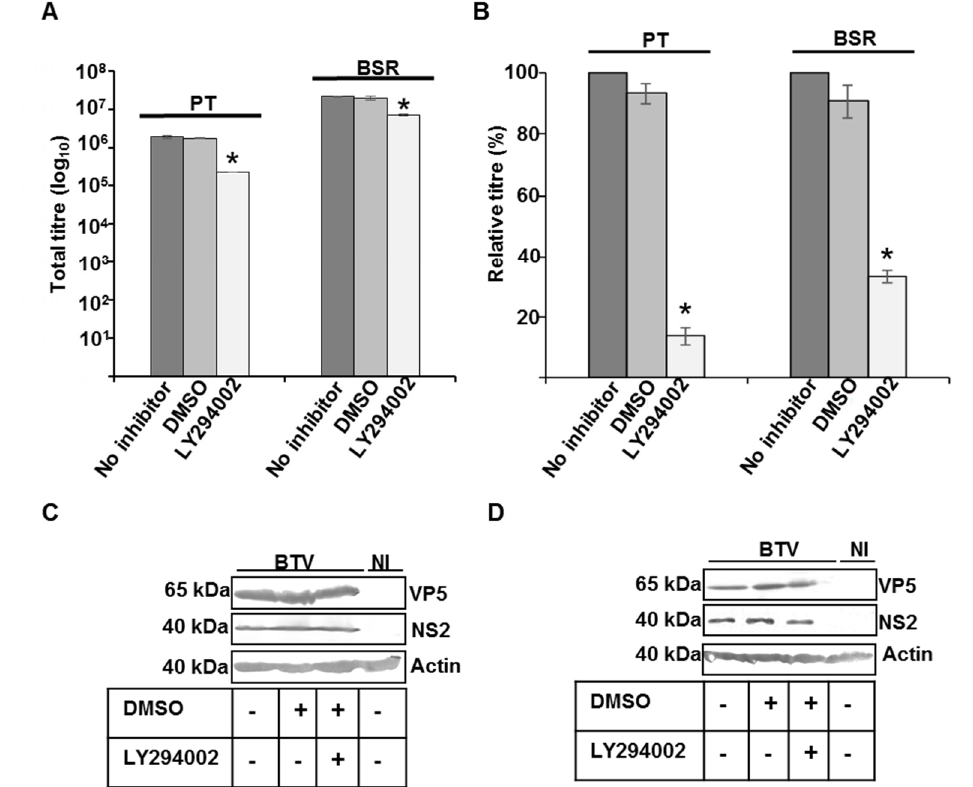
Figure 2. Effect of MVB disruption on BTV. ( A , B ) PT and BSR cells infected with WT BTV at 0.1 MOI were incubated at 12 h pi with LY294002, a specific inhibitor of PI 3-kinase. The total virus ( A ) and relative ( B ) titres at 16 h pi were plotted. The plaque assays were done in triplicate and bars represent standard error. Significant difference in the virus titres were designated by the asterisk ( * ); ( C , D ) Expression of NS2, VP5 and actin in infected PT ( C ) and BSR ( D ) cells. The cells were treated similar to A. Lysates were analyzed by SDS-PAGE and Western blotting. Molecular masses and proteins are indicated on left and right, respectively. Presence or absence of diluent DMSO and inhibitors has been indicated by (+) or ( − ). NI signified uninfected